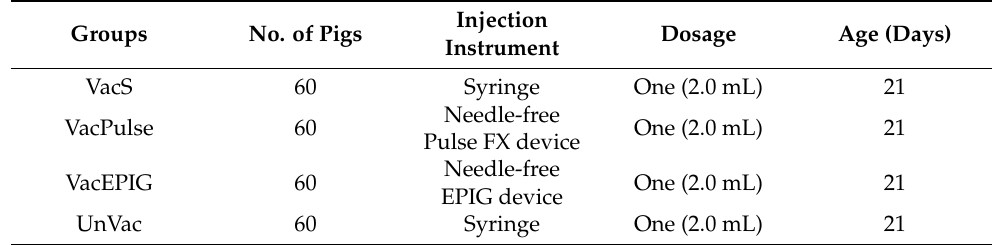
Table 1. Field experimental